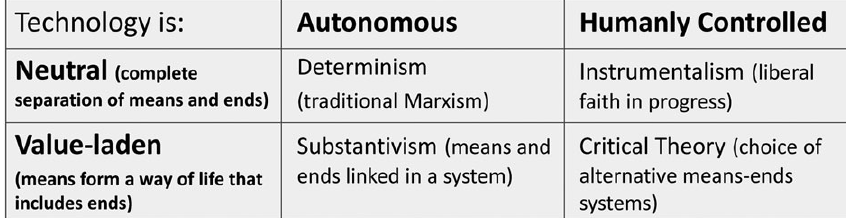
Fig. 2. M. Haklay’s interpretation of Freenberg’s (1999) opinion on